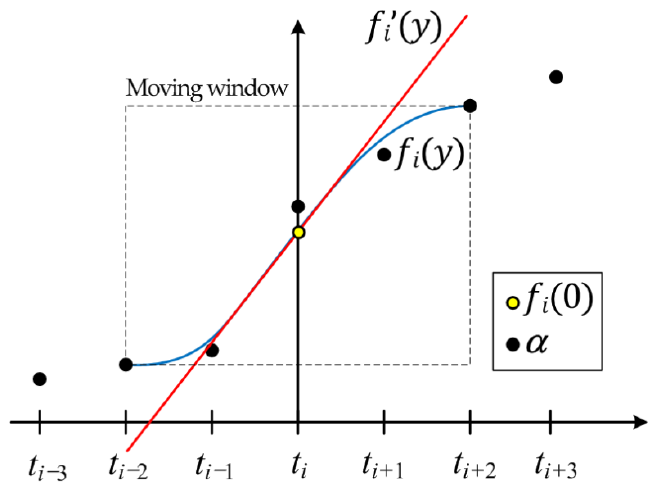
Figure 1. The scheme of the Savitzky–Golay smoothing differentiation filter using five ordinates of the S-curve.